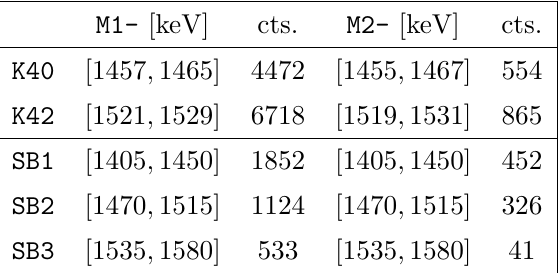
Table 4. Energy ranges and corresponding number of events for the potassium tracking analysis (visualized in (cid:12)gure 6). Note that the windows for two-detector data are larger as the two single- detector energy resolutions are folded in the summed energy spectrum.